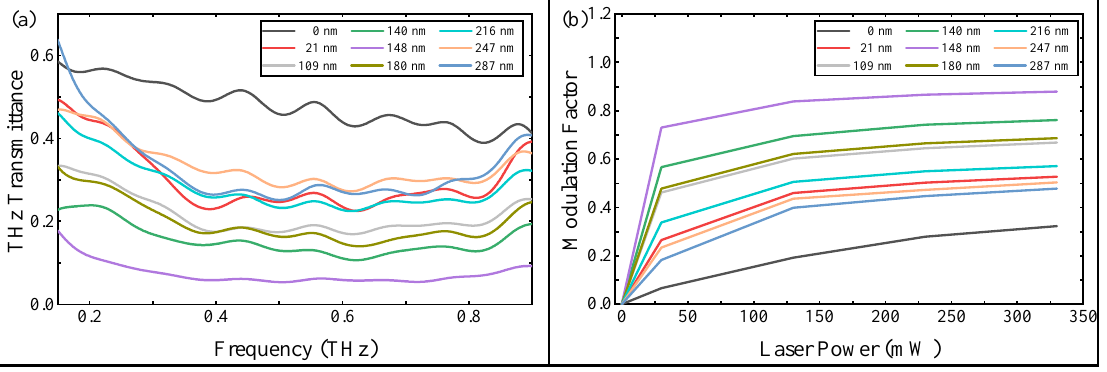
Figure 2. ( a ) THz transmittance for different SiO 2 thicknesses. ( b ) Modulation factor versus CW laser power.